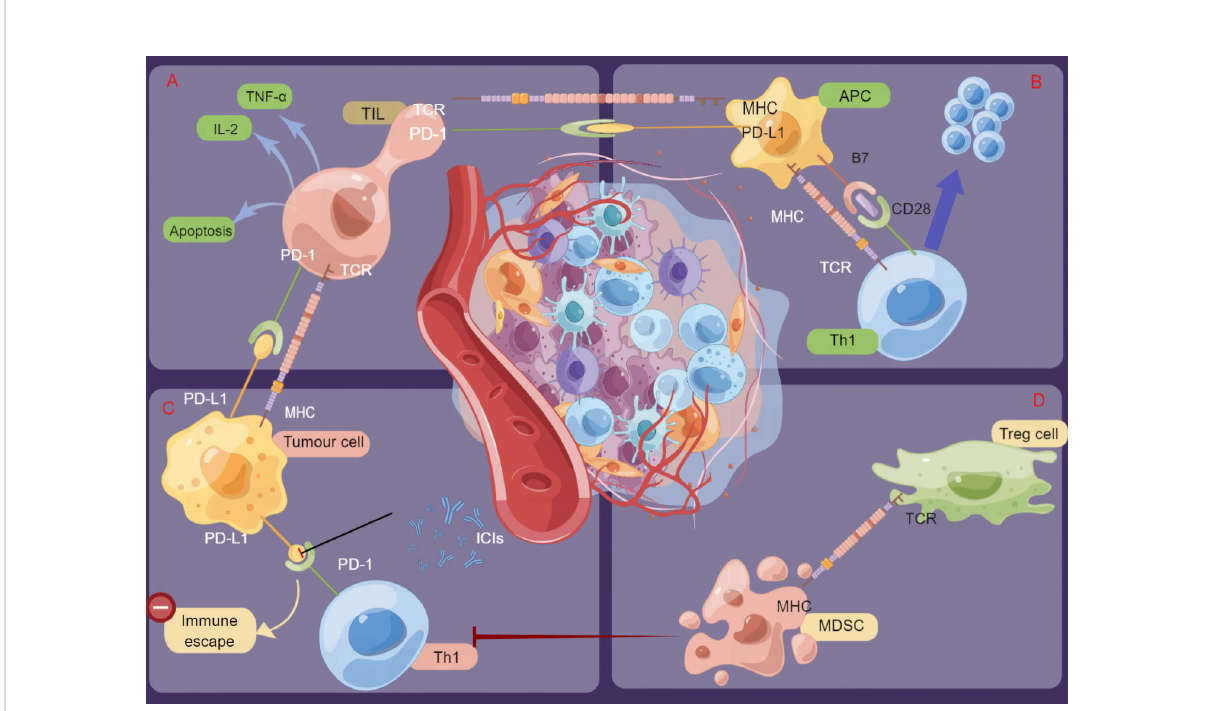
FIGURE 2 Schematic presentation of the mechanisms of immune checkpoint inhibitors (ICIs) and regulation of the tumor immune microenvironment (TIME). Tumor cells bind to PD-1 on the surface of T cells by overexpressing PD-L1 or PD-L2 molecules, thus inactivating T cells for immune escape. ICIs can inhibit these interactions by binding to PD-1 or PD-L1 and then activate cytotoxic T cells and other immune cells to kill tumor cells. (A) . TIL: Speci fi c immune response to tumor cells. (B) APCs present antigens, stimulate T cells and transmit immune signals. (C) Th1: Mediates the cellular immune response and promotes cytotoxic T-cell (CTL) killing. (D) MDSCs: Inhibit the body immune cells to play normal innate and adaptive immune functions; Treg: Suppress the immune response of other cells and control self-tolerance) (by